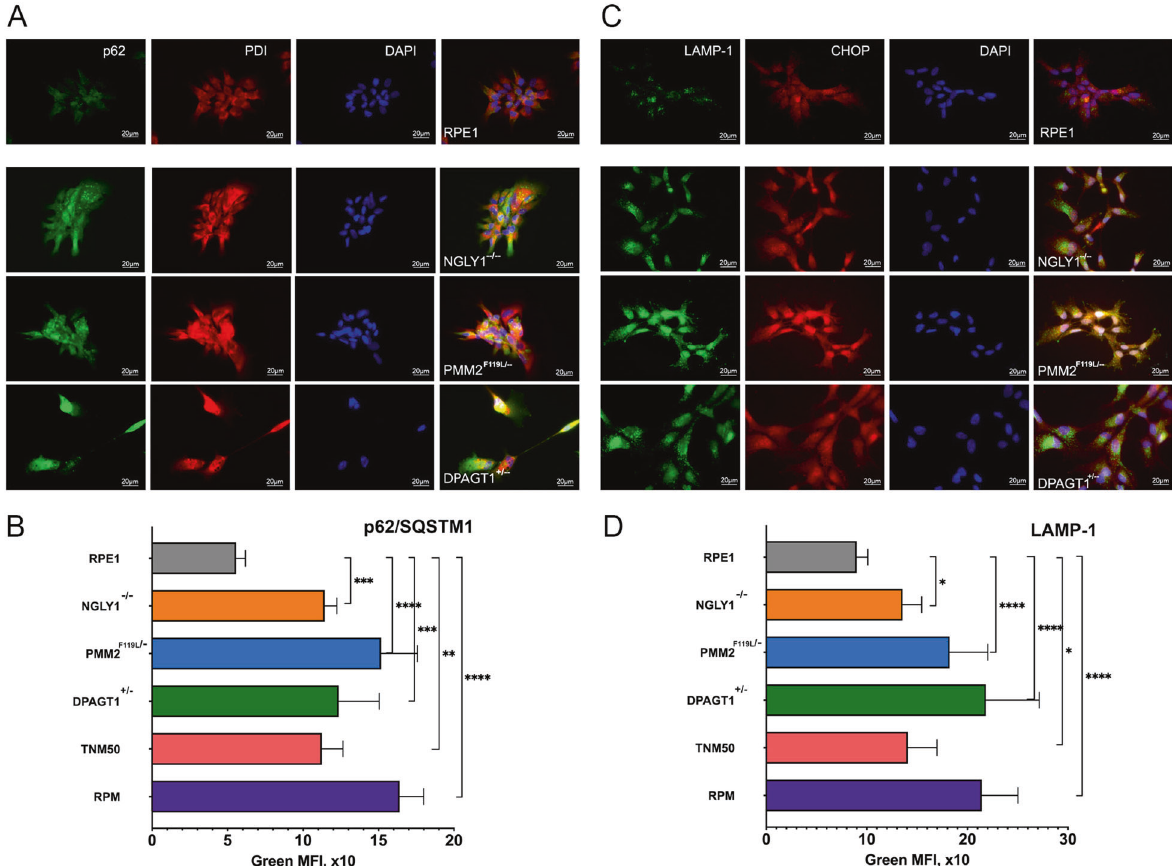
Fig. 4 CDG and CDDG lines exhibit elevated autophagy levels. Representative immuno fl uorescence images of parental RPE-1 cells and CDDG and CDG cell lines stained with antibodies against A p62/SQSTM1 or C LAMP1 in combination with anti-CHOP or anti-PDI antibodies, respectively. Scale bar, 20 µm. Quanti fi cation of p62/SQSTM1 ( B ) and LAMP1 ( D ) staining by fl ow cytometry ( n ≥ 3 per each genotype or treatment). * P < 0.05, ** P < 0.01, *** P < 0.001, **** P < 0.0001, one-way ANOVA followed by Dunnett multiple comparisons